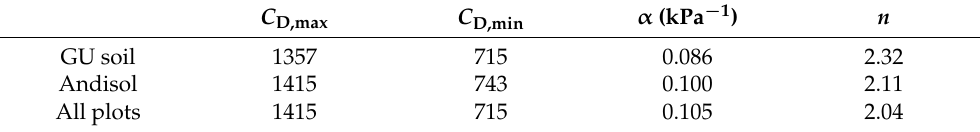
Table 2. Obtained parameters for the modified van Genuchten model that expresses the relationships between the capacitance digital value and the matric potential of the new sensor (Equation (4)). The parameters for the Gifu University experimental field soil (GU soil), the Andisol, and both soils (all plots) are shown. C